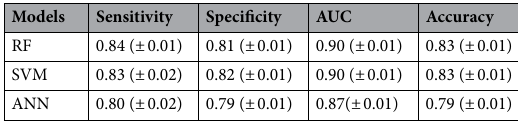
Table 2. Model validation using cross-validation on VEGFR-2 data.